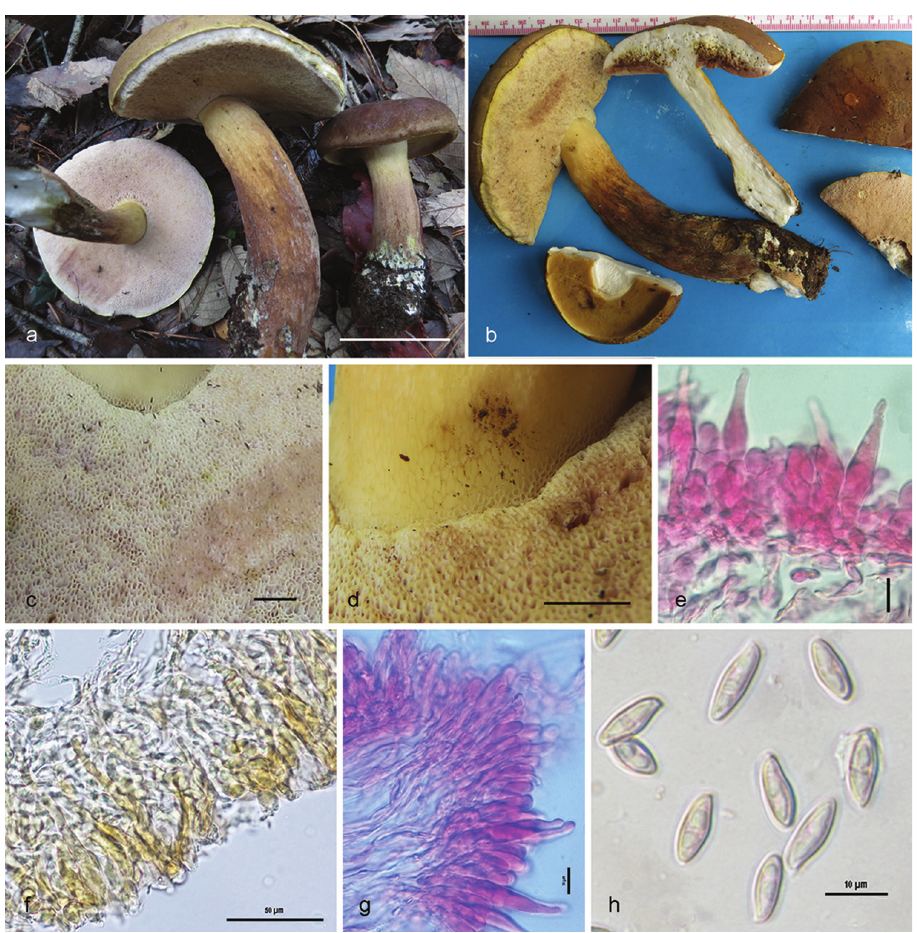
Figure 3. Tylopilus himalayanus (DC 17-25, holotype). a, b Fresh basidiomata in the field and in base- camp c Pore surface after bruising d Surface of stipe apex with reticulation e Pleurocystidia f Pileipellis g Tube edge h Basidiospores. Scale bars: 50 µm ( f ); 10 µm ( e, g, h ); 5 mm ( c, d ); 5 cm ( a ).